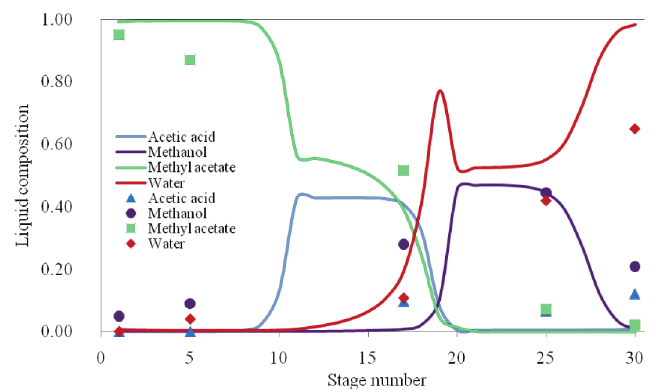
Fig. 5 – Liquid composition profiles versus stage number. Solid lines represent the simulation results from equilibrium stage model, and symbols represent the experimental data 19 .